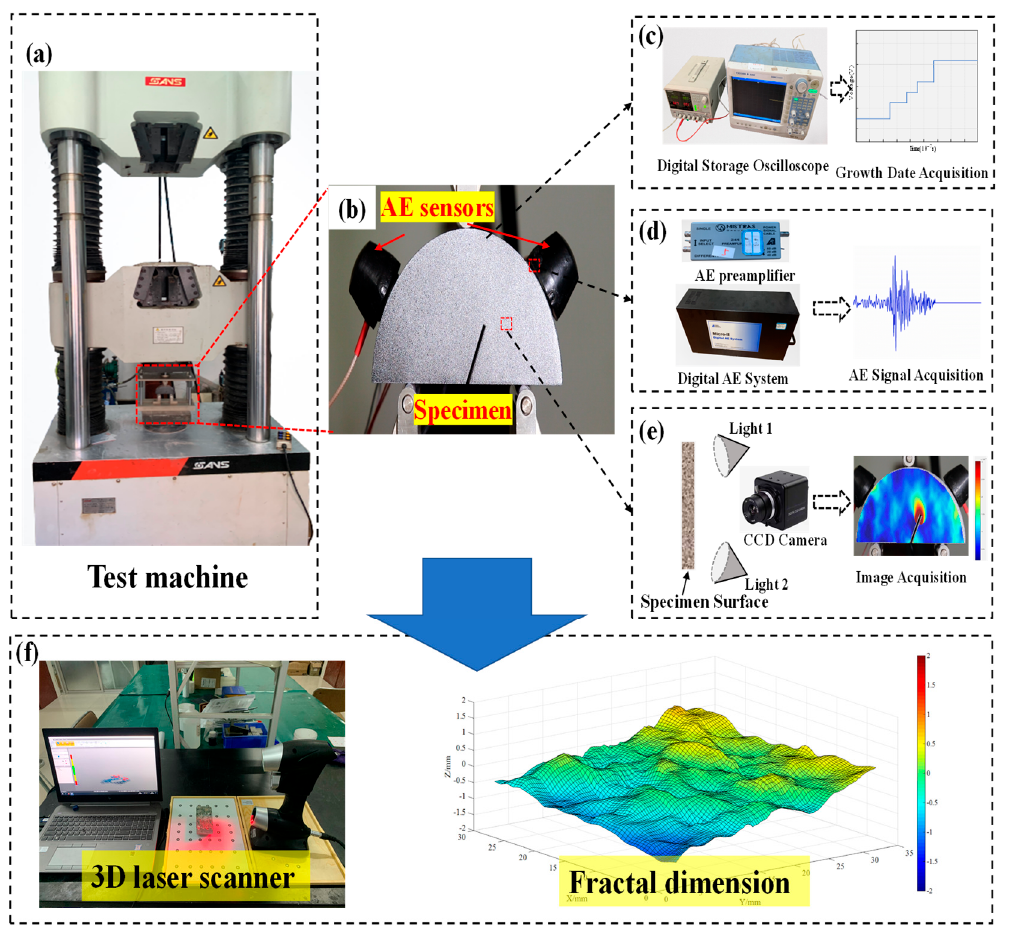
Figure 2. Schematic of the test system. ( a ) SANS − CHT4206 universal material testing machine, ( b ) the photo view of the specimen, ( c ) the measurement system of CPG, ( d ) the AE system, ( e ) the DIC measurement, and ( f ) the calculation of the fractal